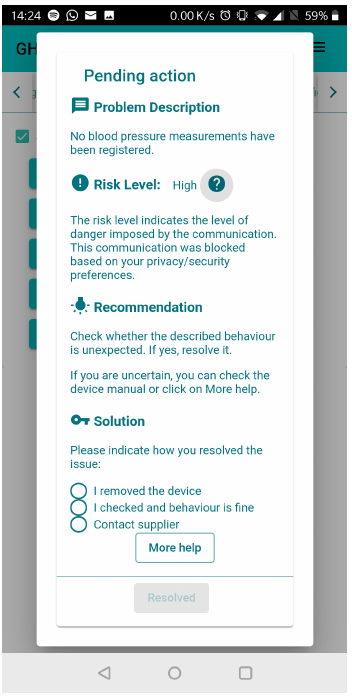
Figure 12. Pending action.